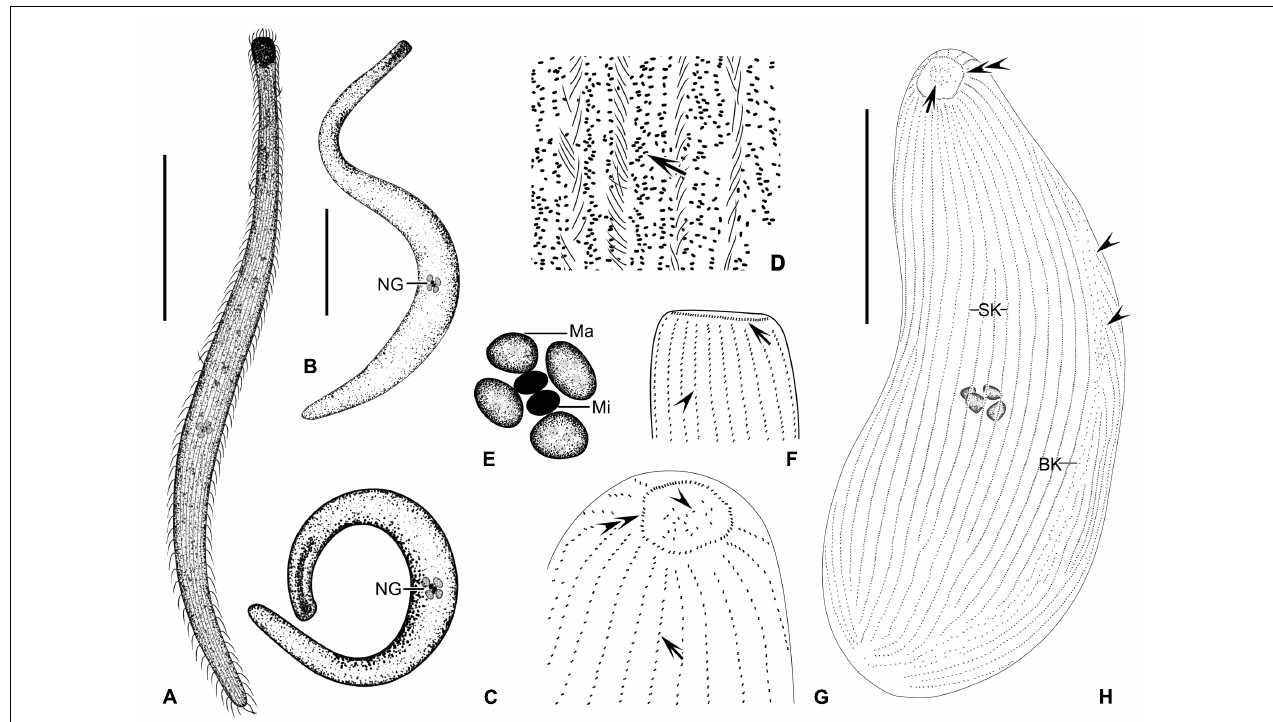
FIGURE 4 | (A–H) Trachelolophos monocaryon (Dragesco, 1965) comb. nov. in vivo (A–D) and after protargol staining (E–H) . (A,B) Typical individual. (C) An extremely curved cell. (D) Distribution of cortical granules (arrow) between somatic kineties. (E) Nuclear group. (F) Lateral view of head showing circumoral kinety (arrow) and somatic kineties (arrowhead). (G) Apical view of head, showing the ciliary tuft (arrowhead), somatic kineties (arrow), and circumoral kinety (double arrowheads). (H) Overview showing the multiple macronuclei, ciliary tuft (arrow), circumoral kinety (double arrowheads), and secant system (arrowheads). BK, bristle kinety; Ma, macronuclei; Mi, micronuclei; NG, nuclear group; SK, somatic kineties. Scale bars = 200 µ m (A,B) ; 80 µ m (H) .